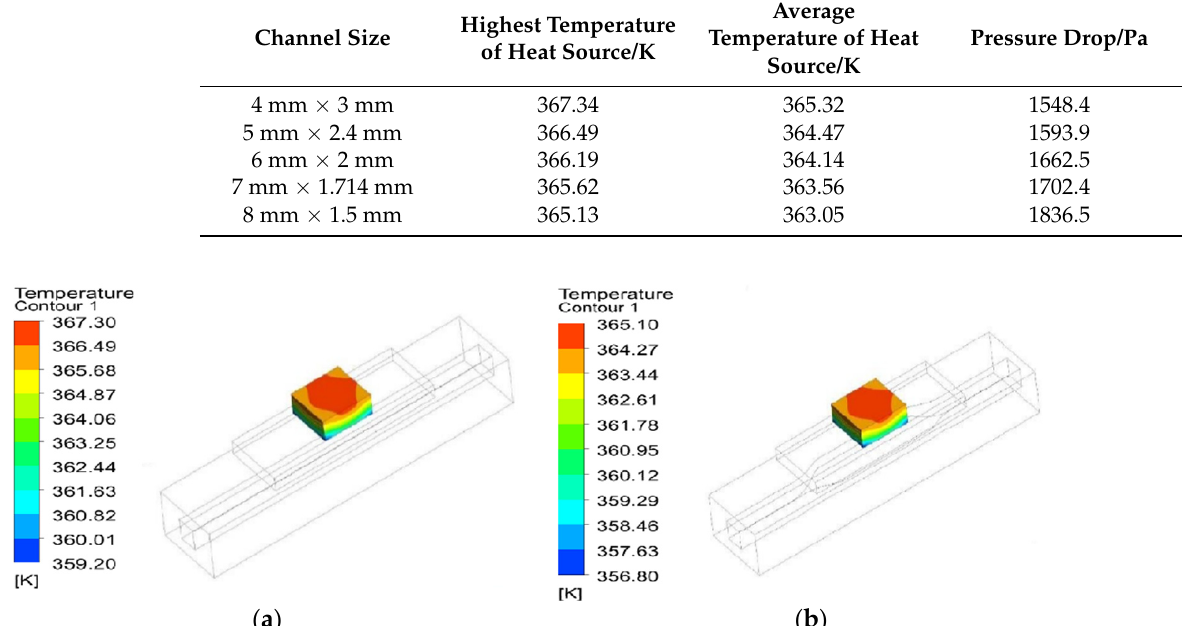
Figure 9. Temperature distribution of different channel sections: ( a ) 4 mm × 3 mm; ( b ) 8 mm × 1.5 mm.